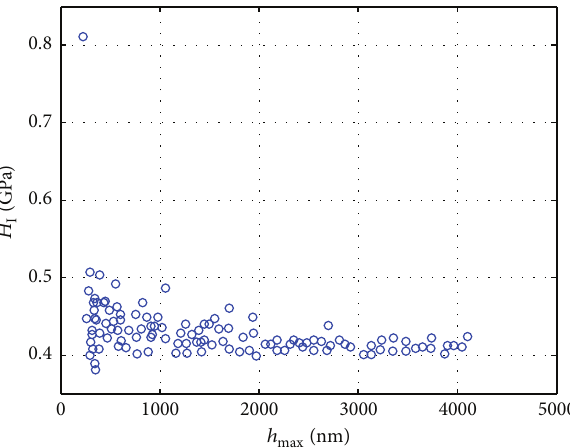
Figure 13: Effect of tip bluntness on the indentation size effect in PMMA( 𝐻 corrected I and 𝐻 uncorrected I representtheindentationhardness with and without considering the effect of tip bluntness, resp.) where 10 s loading, holding, and unloading times together with strain rate of 0.1 s −1 were imposed